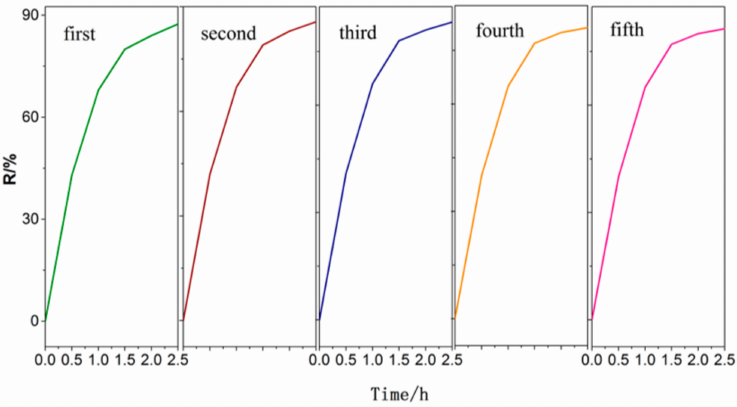
Figure 9. R of 2,4,6-TCP by regenerated Zn 2+ -Al 3+ -C4H4O6 2 −